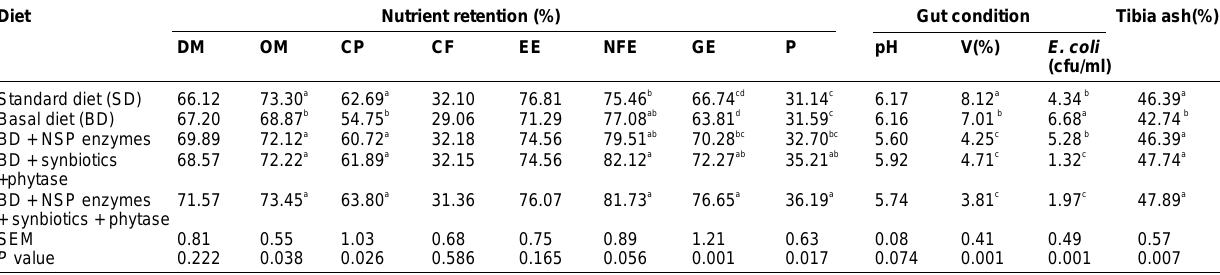
Table-6. Nutrient retention, intestinal pH, viscosity, E. coli and tibia ash content of broilers fed basal diet supplemented with NSP enzymes, synbiotics and phytase Diet DM